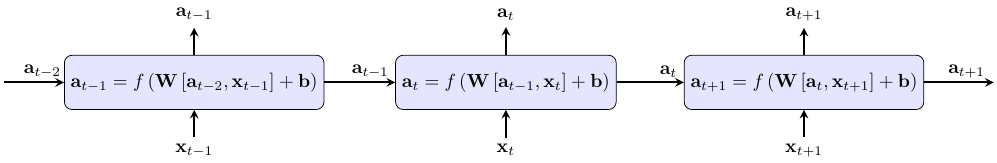
Figure 3. Unfolded view on a recurrent neural network. The neural network is extended by an additional loop which allows the use of previous information for the subsequent